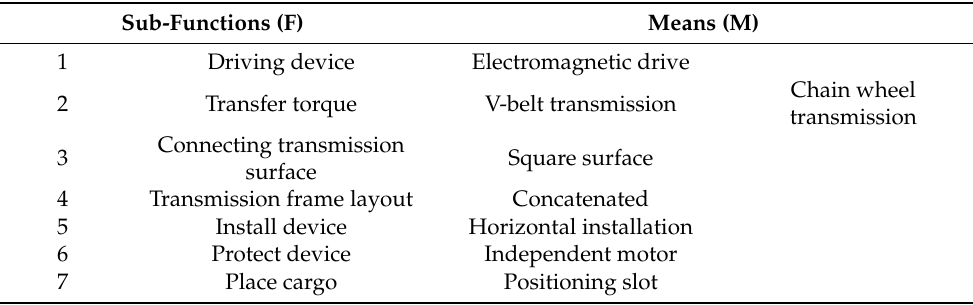
Table 6. The transmission device conceptual design refined morphological